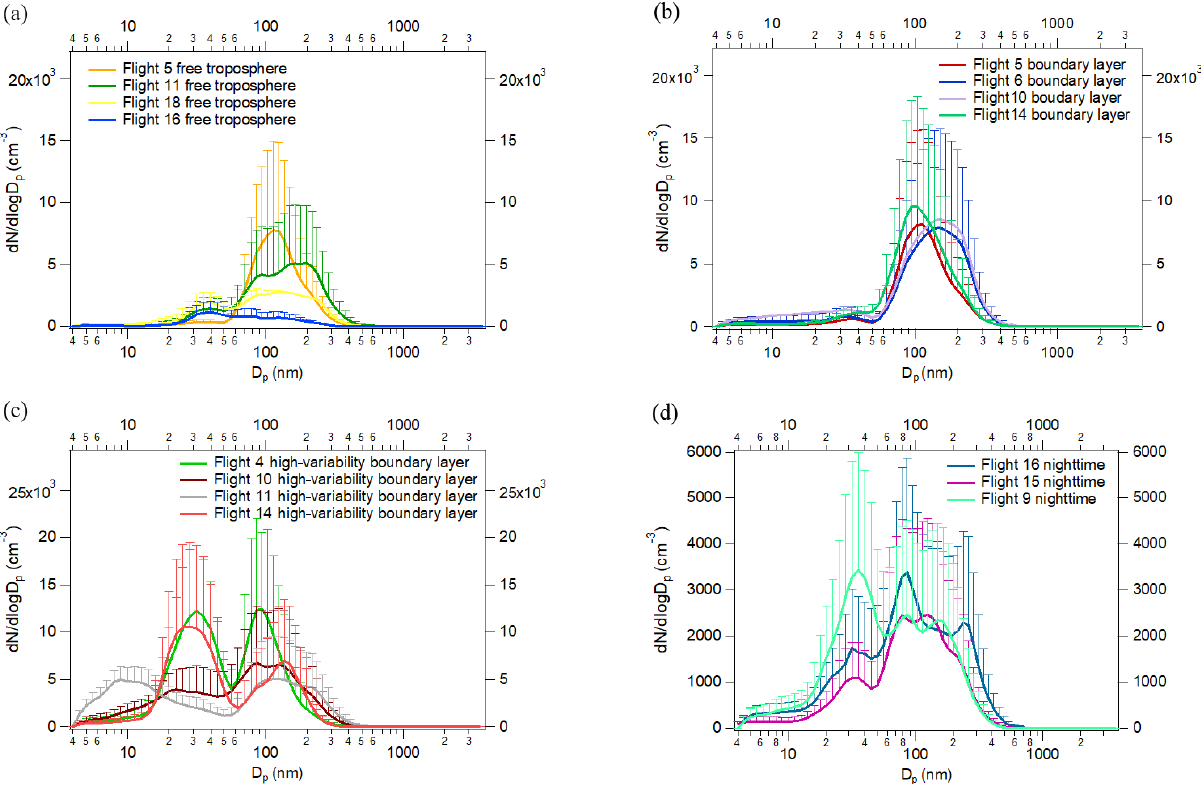
Figure 2. Average particle number size distributions for (a) free-tropospheric conditions, (b) within the boundary layer, (c) during segments with high variability in total aerosol number, and (d) during nighttime passes. Error bars represent the 75th percentile of the distributions within each segment.